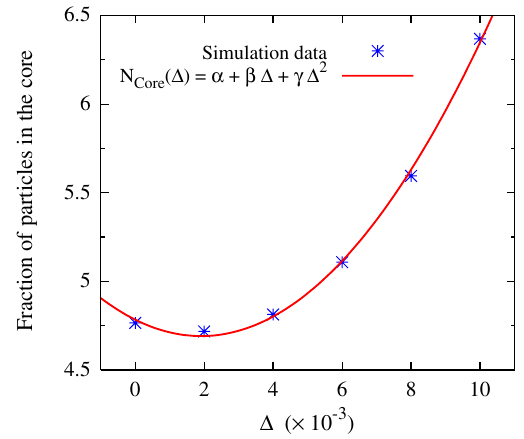
FIG. 8. (Color) Fraction of particles remaining in the beam core as a function of (cid:2) . The fitted parabola is also shown. The numerical simulations are performed with (cid:5) ¼ 0 : 08 for the initial